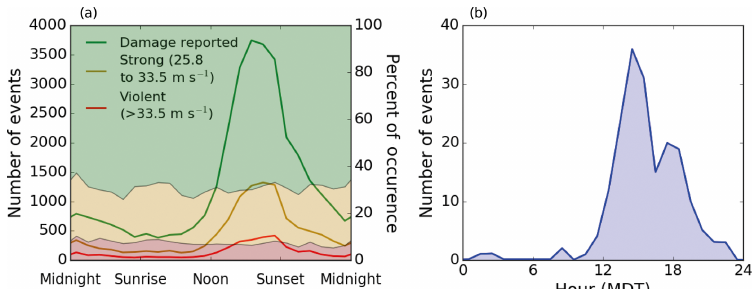
Figure 1. (a) The frequency of wind gusts of varying severity throughout the day (solid lines) overlaying the percentage of each wind gust severity category. Red, yellow, and green coloring correspond to violent gusts (greater than 33.5ms − 1 ), strong gusts (between 25.8 and 33.5ms − 1 ), and events with reported damage but no estimated wind speeds, respectively. Data have been adapted from Kelly et al. (1985), where the times have been converted to normalized solar time (NST). (b) Time of occurrence of the downbursts observed in the JAWS campaign; regenerated data from Fig. 4 in Wakimoto (1985).